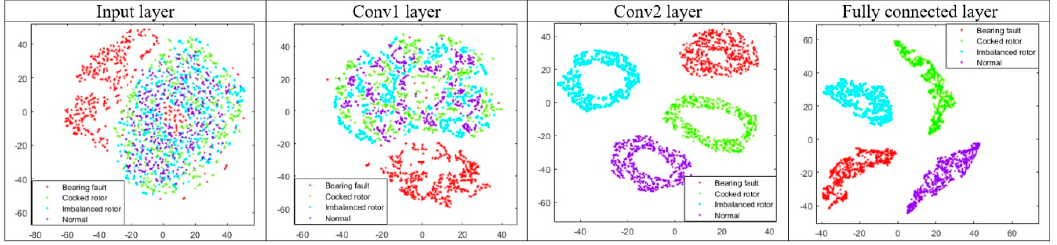
Figure 8. t-SNE activations representations.